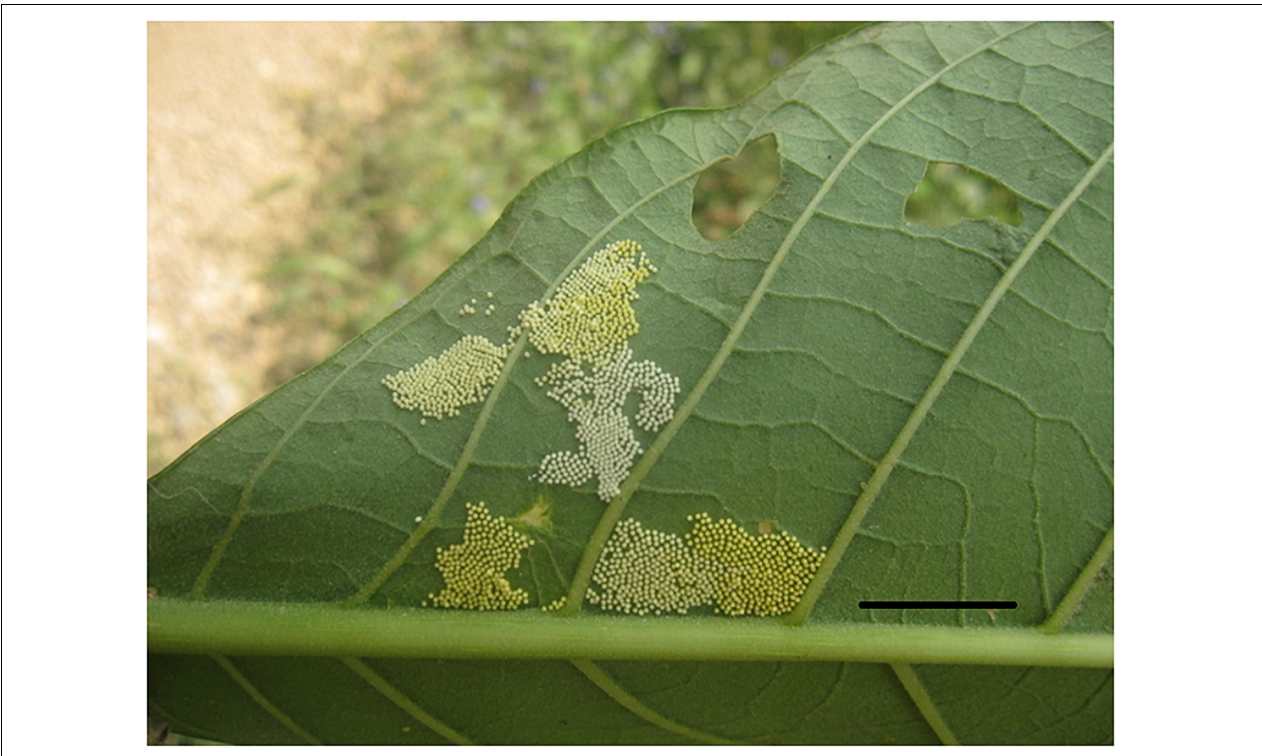
FIGURE 1 | Multiple clusters of Ithomia spp., eggs on a single leaf. Black bar indicates 1